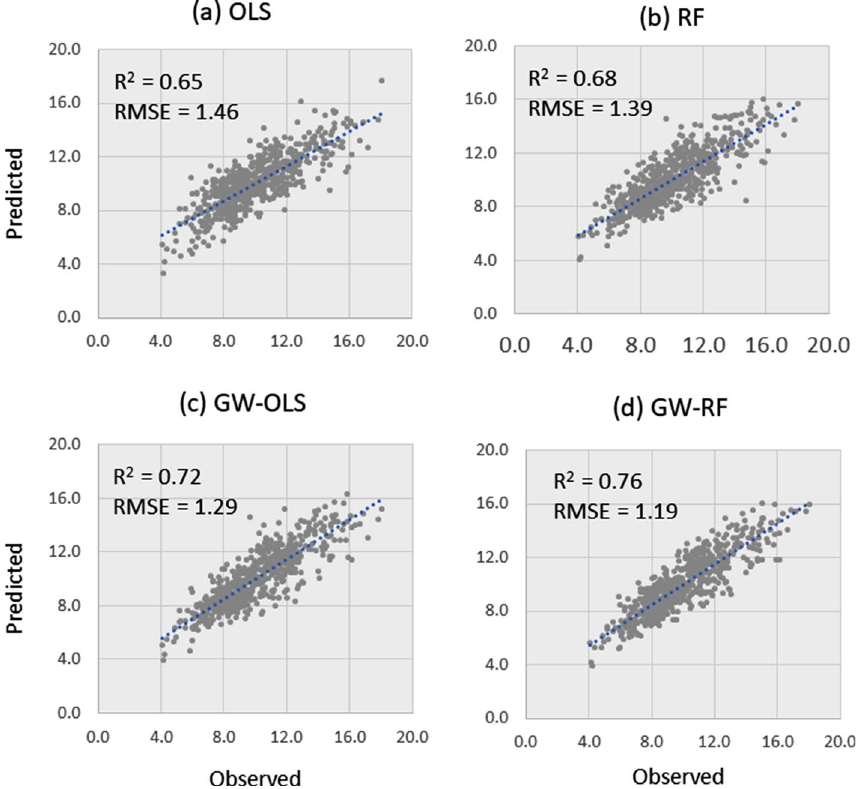
Figure 7. 1:1 plot of observed versus predicted T2D prevalence (%) in 624 test counties for the ( a ) OLS, ( b ) RF, ( c ) GW-OLS, and ( d ) GW-RF regression models. All models were trained with data from 2484 counties (see supplementary information and Figure